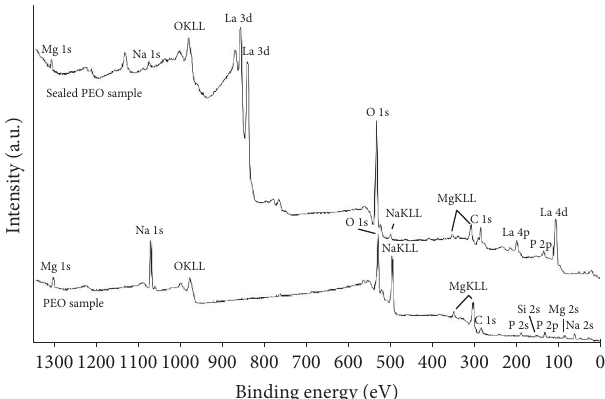
Binding energy (eV)